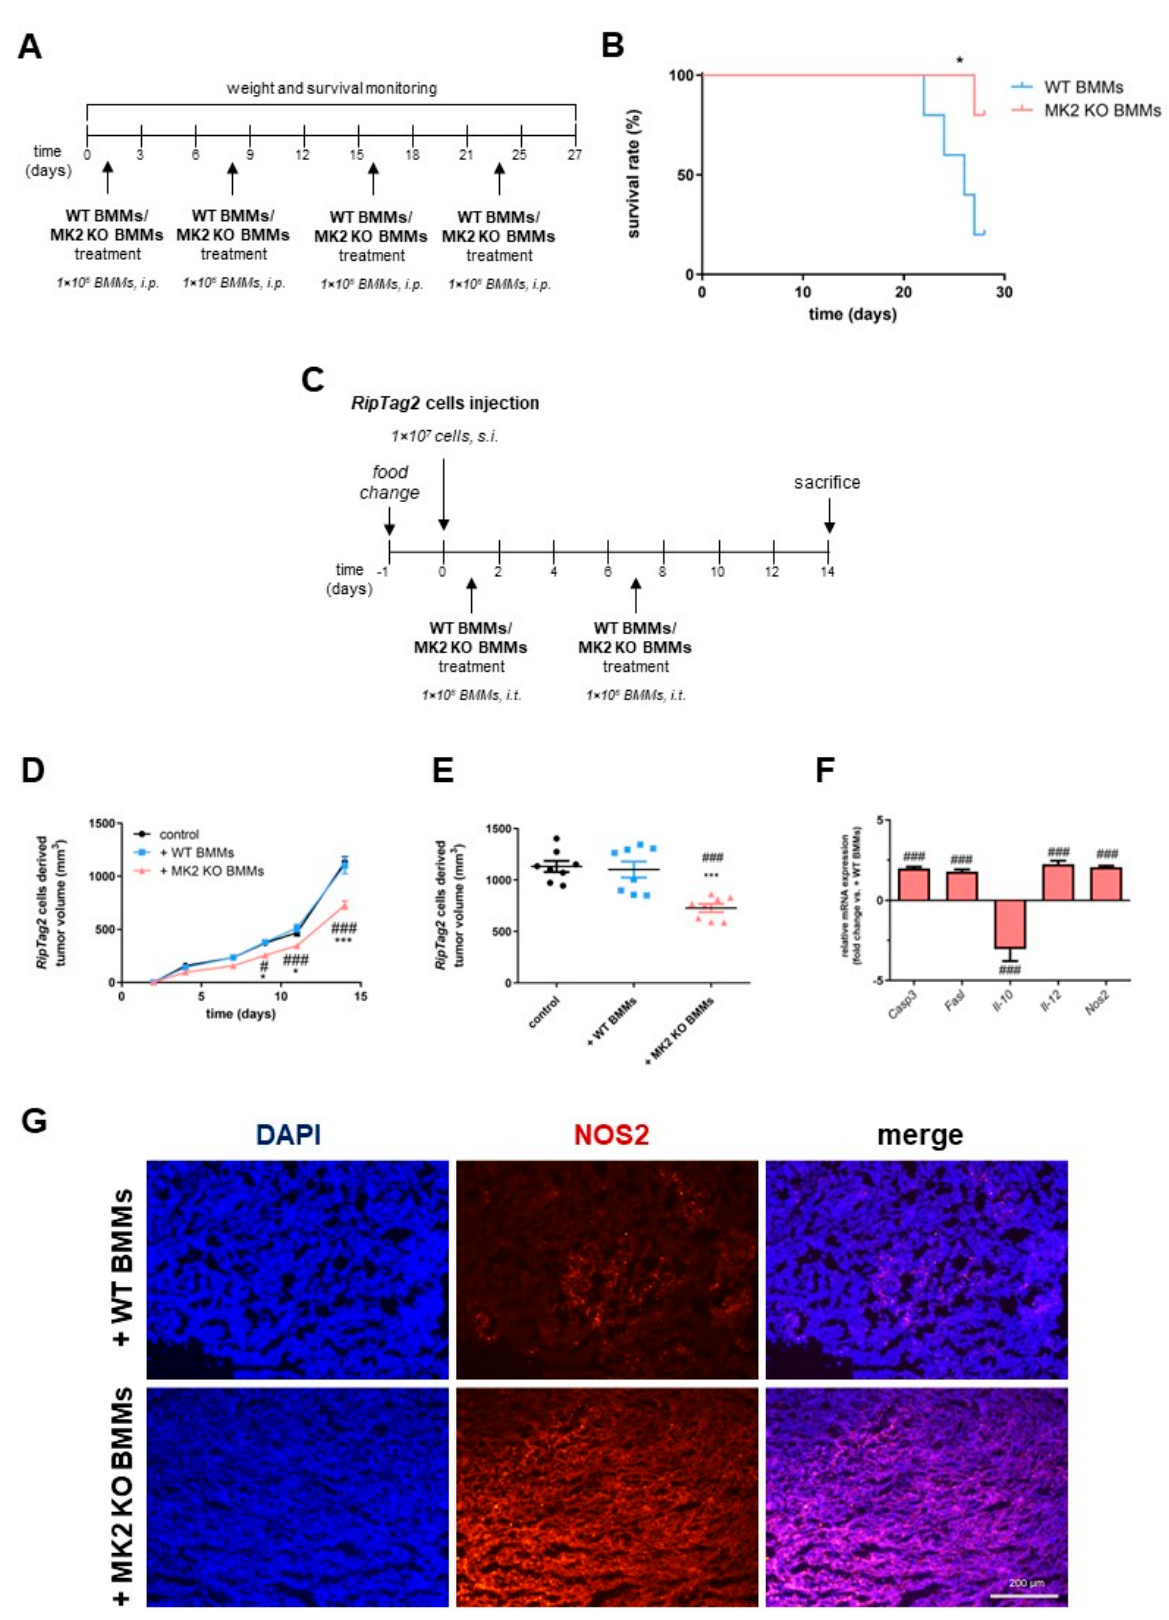
Figure 5. Adoptive transfer of MK2 KO macrophages improves survival of RipTag2 mice and suppress growth of cell line allograft tumors . The RipTag2 mice were treated with macrophages as shown in a timeline ( A ). The Kaplan–Meier curve ( B ) shows improved survival of mice receiving MK2 KO macrophages compared to WT macrophages, n = 8 in each group. Rag1 KO mice receiving